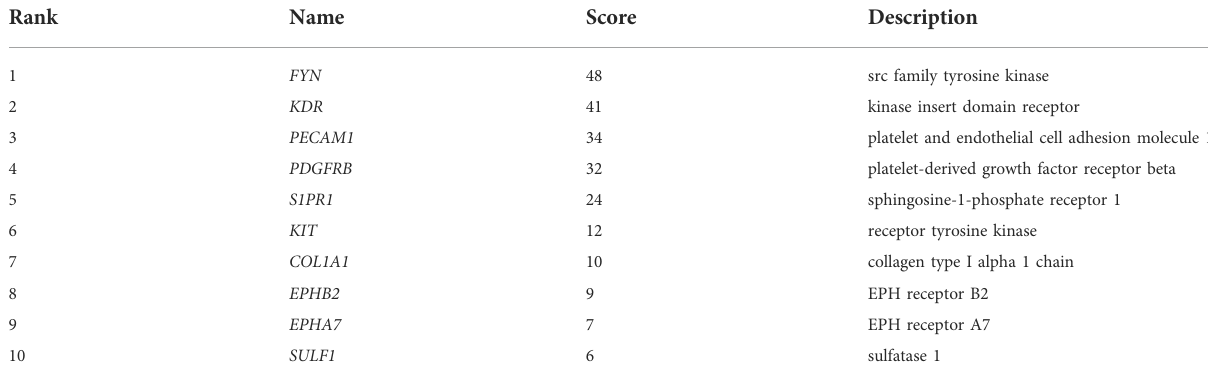
TABLE 3 Top 10 overlapping genes (hub genes) with highest connectivities.